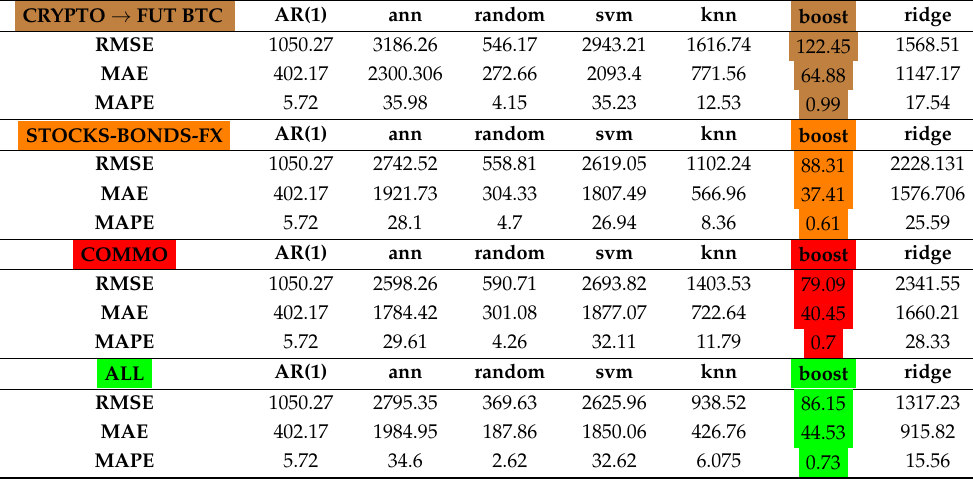
Table 4. Full sample forecasting results for the CME Bitcoin December 2019 Futures